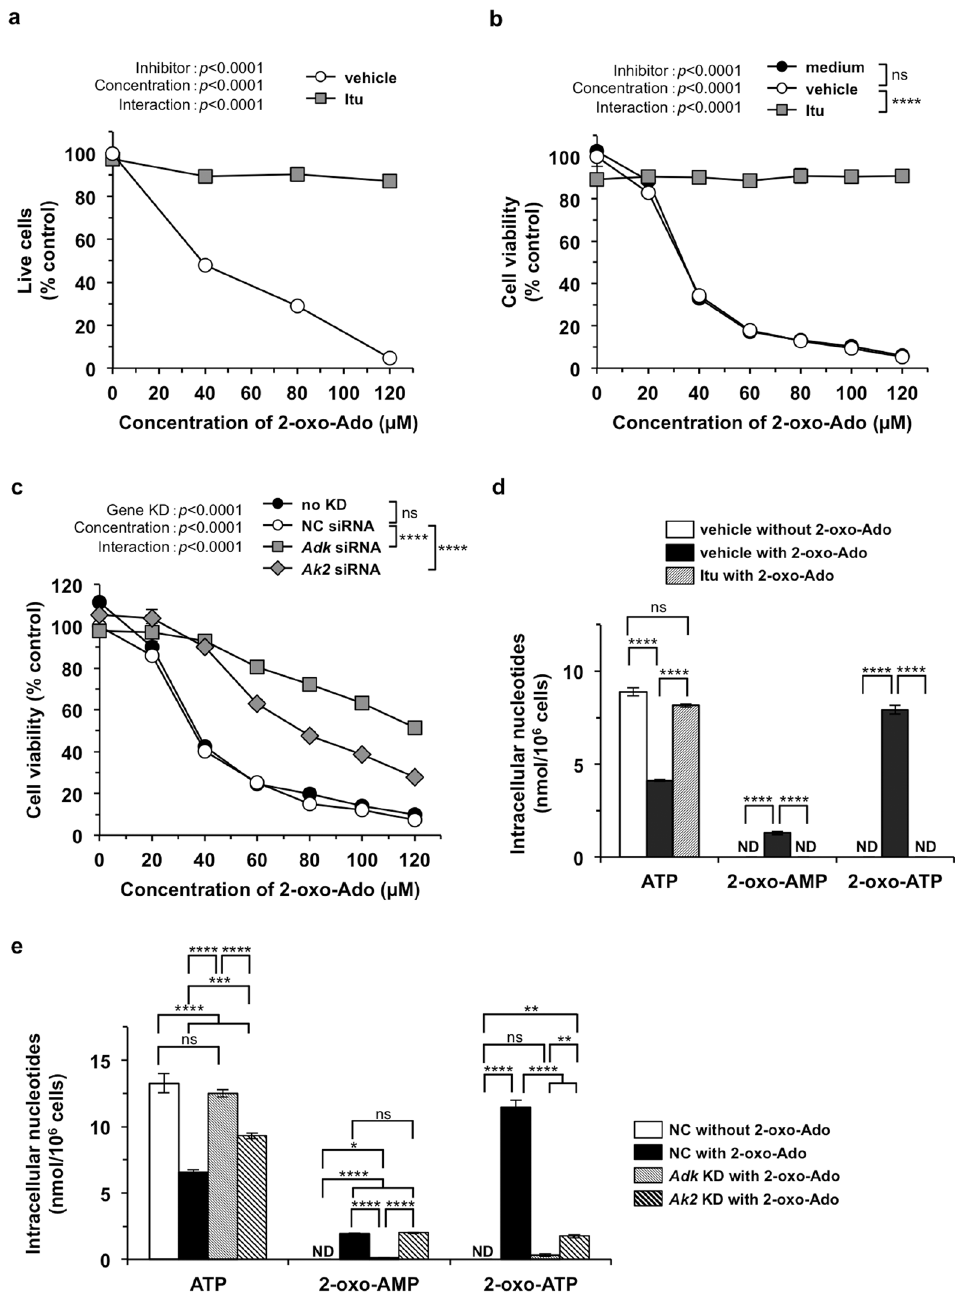
Figure 2. 2-Oxo-Ado-induced cell death requires intracellular phosphorylation of 2-oxo-Ado initiated by adenosine kinase (Adk). ( a ) The number of live T9 cells was determined by trypan blue exclusion after incubation for 24 h in the presence of various concentrations of 2-oxo-Ado with or without 0.1 µ M 5-Iodtubercidin (Itu), an Adk inhibitor. Vehicle control, 0.1% DMSO. Values (% control) of the number of live cells relative to that of control cells in the absence of 2-oxo-Ado are shown as the mean ± SD of three experiments. ( b , c ) Viability of T9 cells was determined by WST-8 assays after incubation for 24 h in the presence of various concentrations of 2-oxo-Ado. ( b ) Cells were incubated with 0.1 µ M Itu, vehicle (0.1% DMSO), or without them (medium). ( c ) Cells were treated with target siRNA for gene-knockdown (KD) or negative control (NC) siRNA as the control at 48 h before commencement of 2-oxo-Ado treatment. Non-KD-treated cells (no KD) were also used. Values (% control) of cell viability relative to that of control cells in the absence of 2-oxo-Ado are shown as the mean ± SD of three experiments. ( d , e ) Intracellular nucleotide concentrations of T9 cells were determined by HPLC after incubation for 6 h in the presence or absence of 100 µ M 2-oxo-Ado. Cells were treated with the vehicle (0.3% DMSO), 0.1 µ M Itu ( d ), or siRNAs against Adk and Ak2 ( e ). Results are shown as the mean ± SD of three experiments. ND; not detected. ( a – e ) Results were statistically analysed by two-way ( a – c ) or one-way ( d , e ) ANOVA and post-hoc Tukey’s HSD test among inhibitor conditions ( b ), different KD conditions ( c ) or each kind of nucleotide ( d , e ). ns, not significant; * p < 0.05; ** p < 0.01; *** p < 0.001; and **** p <